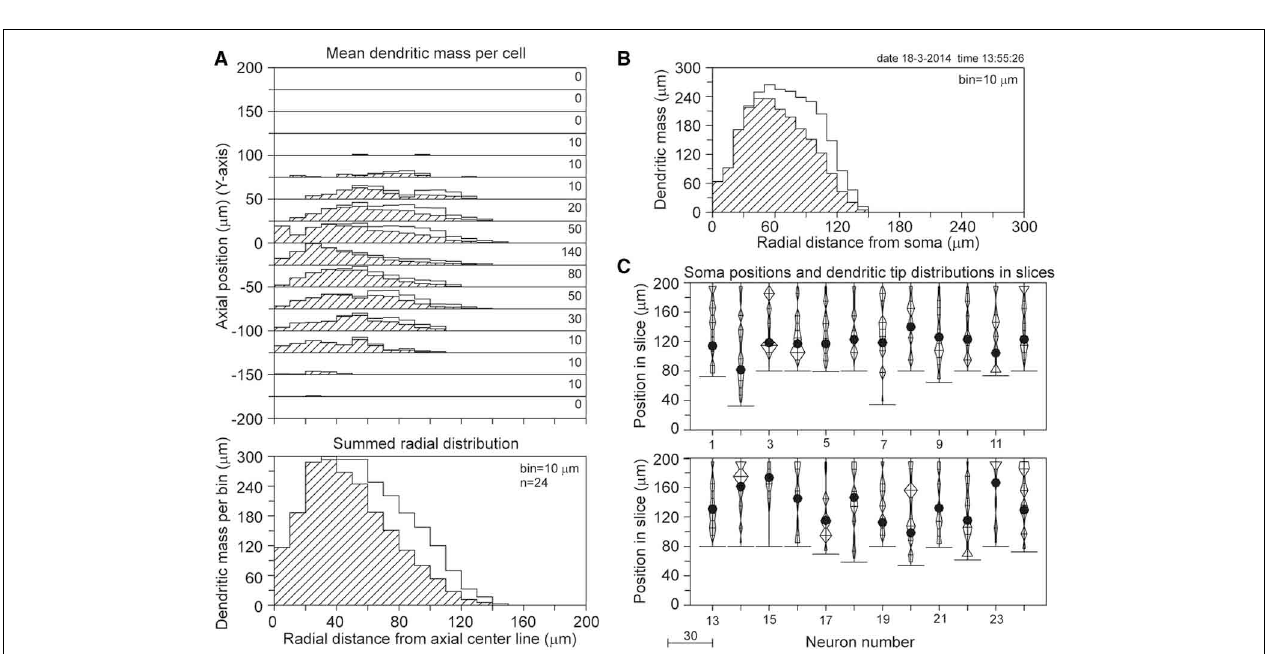
FIGURE 11 | Mass completion of basal dendrites of 24 rat visual cortex L2/3 pyramidal neurons (age 90 days PN), reconstructed from 120 µ m thick slices by Parnavelas-Uylings (Uylings et al., 1994). For the description of the different panels see the legend of Figure 4 . Lacking information on the